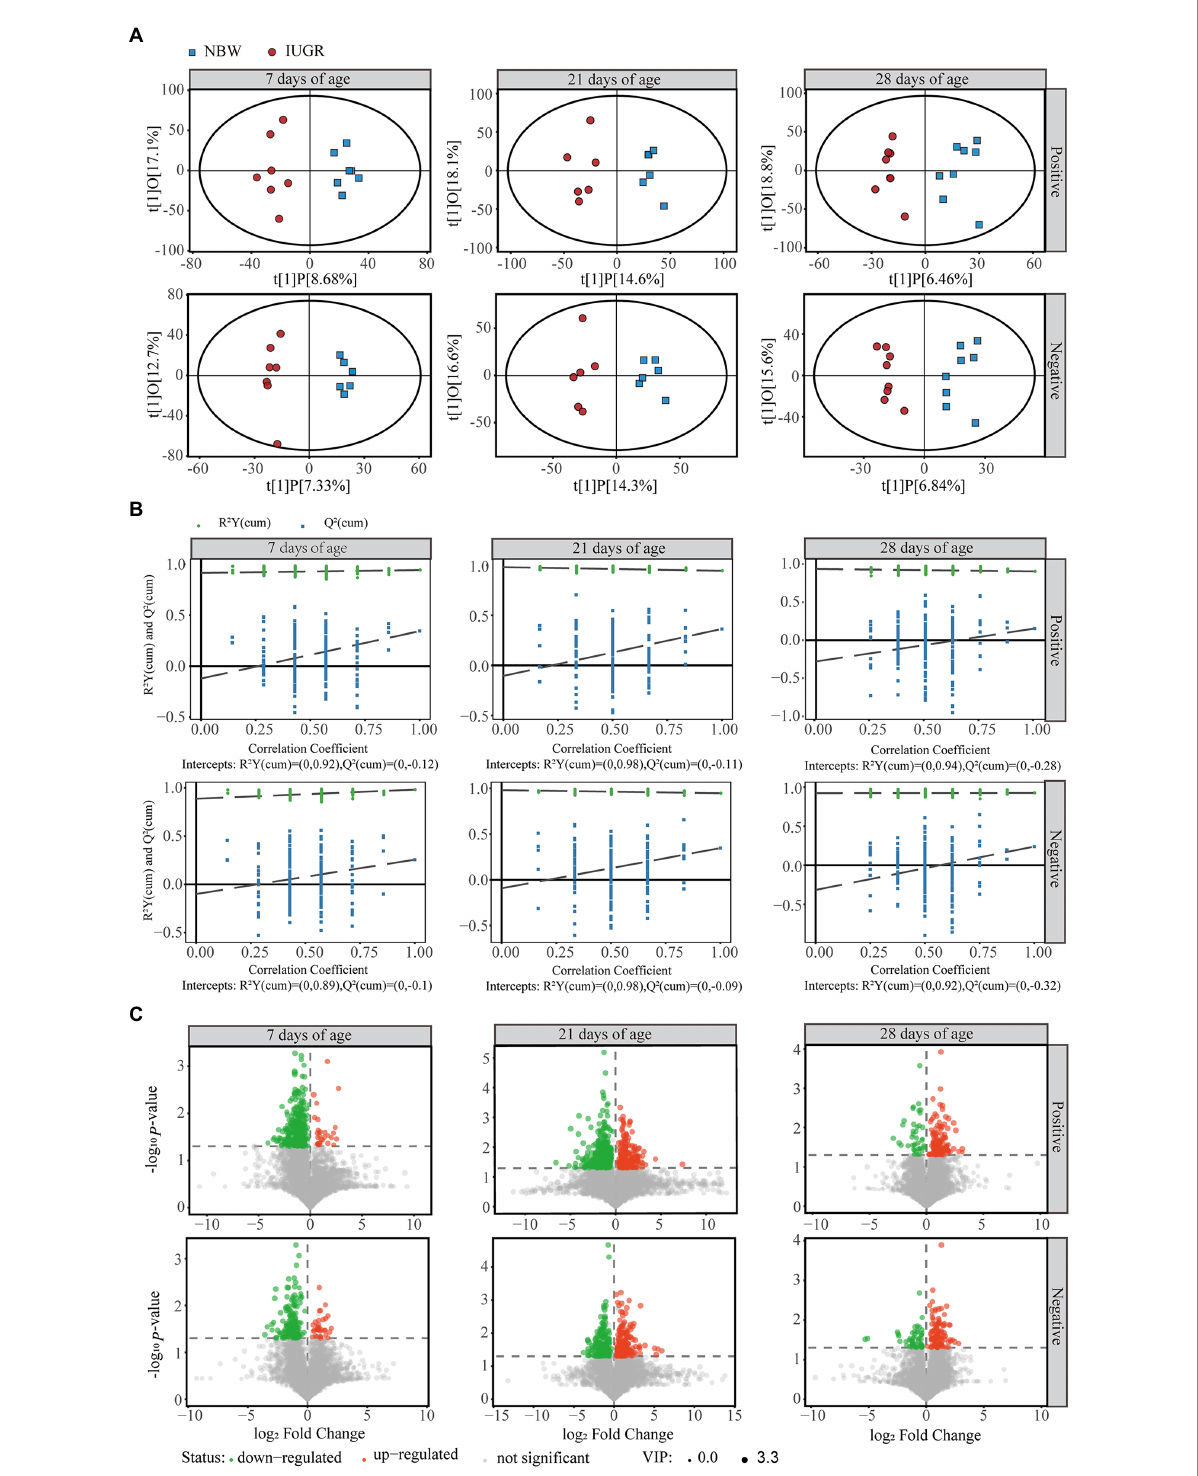
FIGURE 4 Differences in colonic metabolome profiles between the intrauterine growth restriction (IUGR) and normal birth weight (NBW) piglets at 7 ( n = 7), 21 ( n = 6), and 28 ( n = 8) days of age. (A) The score plots of Orthogonal projections to latent structures-discriminant analysis (OPLS-DA) model based on the non-target metabolomics for the data from positive and negative ion modes of the colonic contents. Red and blue represent the IUGR and NBW piglets, respectively. (B) The permutation test results of OPLS-DA. (C) Volcano plots of positive and negative ion modes based on the non-target metabolomics of the colonic contents. Each symbol represents the identified metabolite, orange represents significantly up-regulation of different metabolites, green represents significantly down-regulation of different metabolites, and gray represents the metabolites those did not